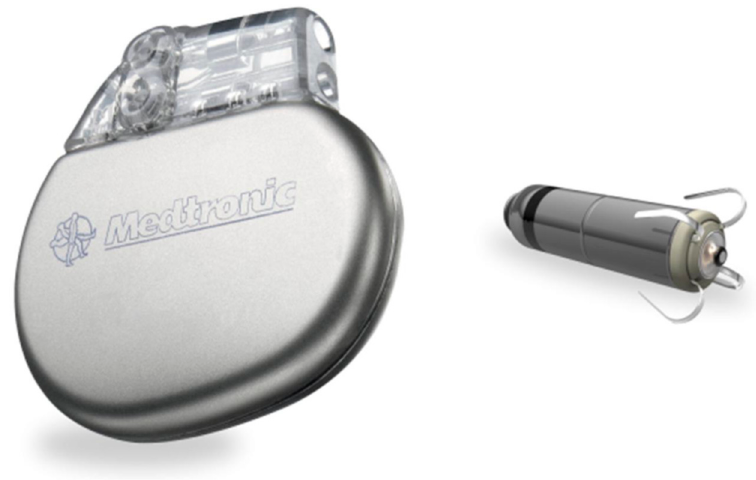
Figure 1. A typical dual-chamber pacemaker ( left ) and the Micra ( right ). Reproduced with permission from reference [26] and Medtronic,